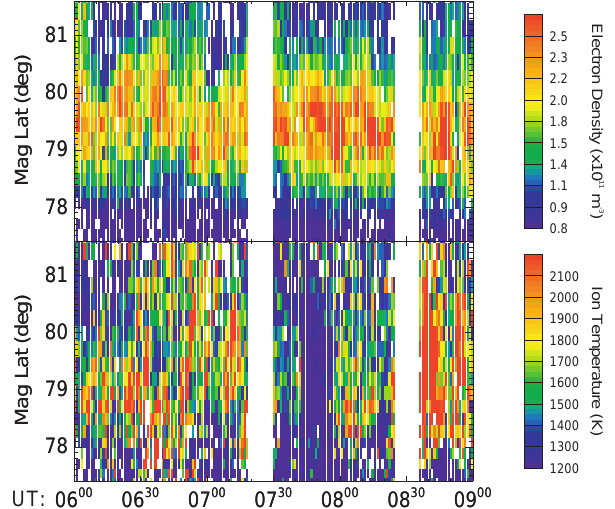
Fig. 5. Ionospheric electron density and ion temperature measure- ments made by the ESR during the interval of